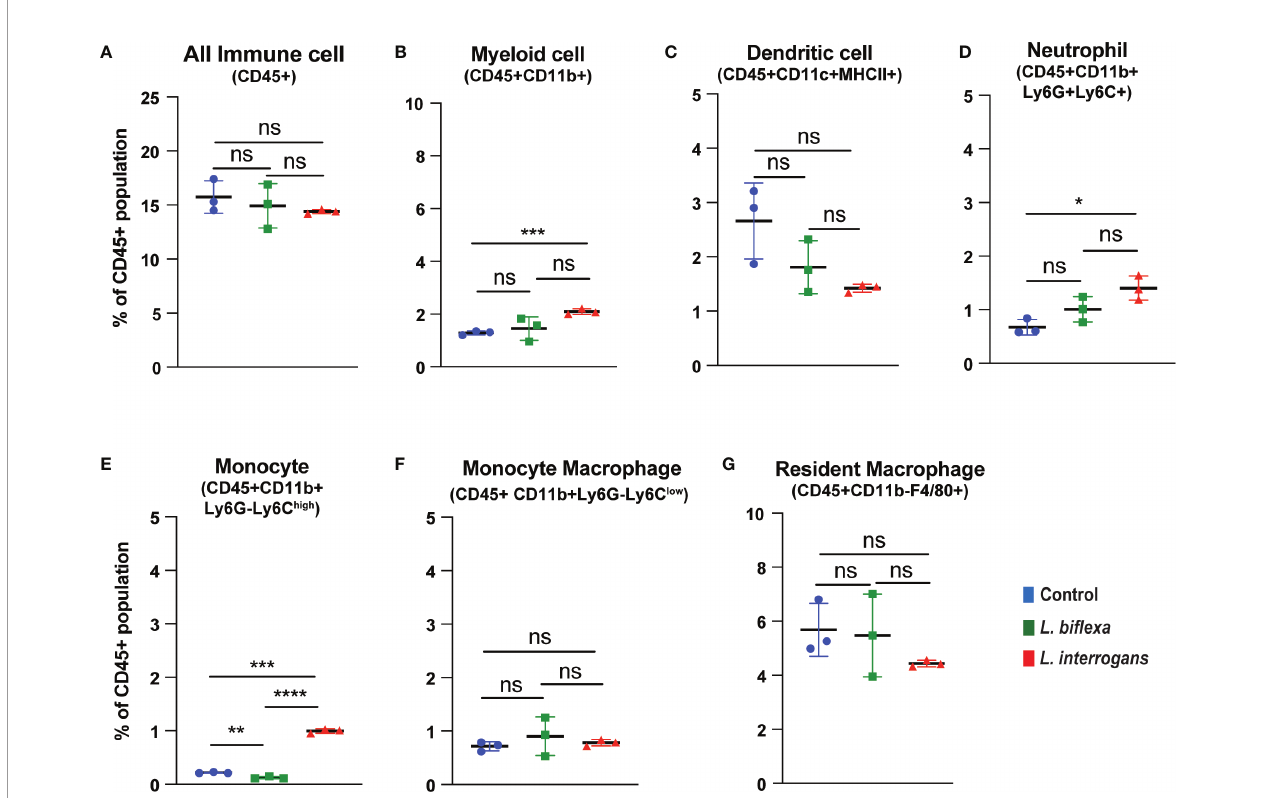
FIGURE 2 | Apoptotic cell death among different immune cells in spleen at 72h post infection. Annexin V + /PI - cells were considered as zone of apoptosis in (A) All Immune Cells, (B) Myeloid cell, (C) Dendritic cell, (D) Neutrophil, (E) Monocyte, (F) Monocyte-Macrophage and (G) Resident Macrophage. Plots are represented as % of CD45+ population. Statistical analysis was performed using unpaired student t-test with Welch ’ s correction, *p < 0.05, **p < 0.01, ***p < 0.001, ****p < 0.0001; ns, not-signi fi cant; n = 3 mice per group. Data represents one of two independent experiments; N = 7 mice per